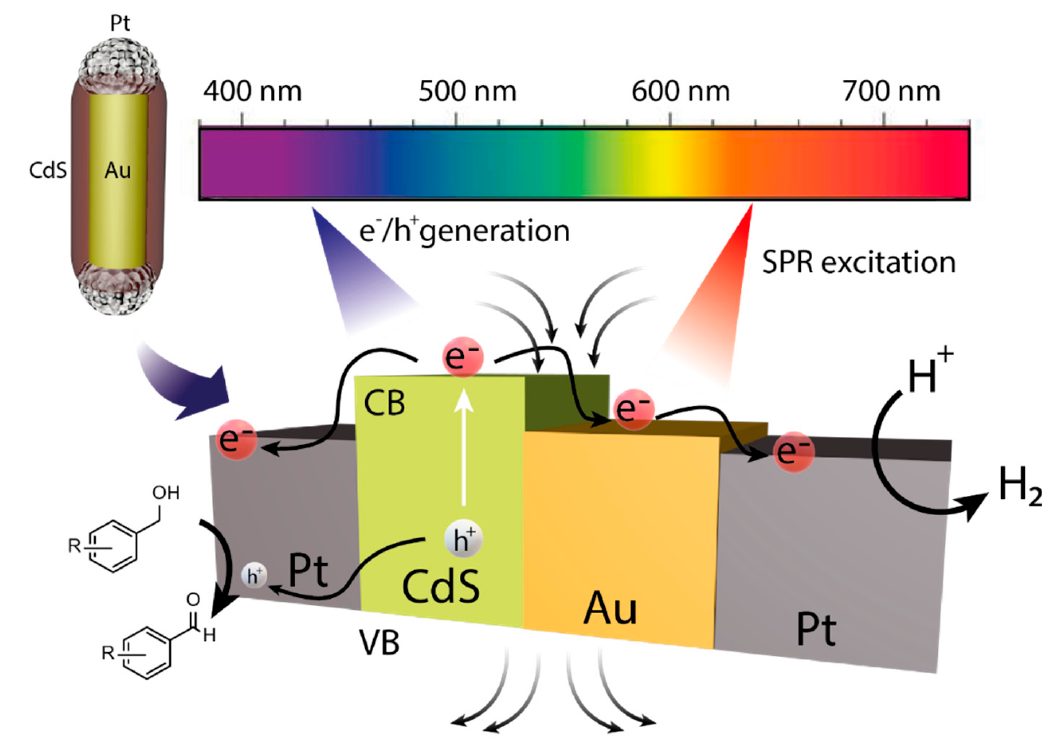
Figure 10. Schematic representation of the energy band multichannel in bimetallic@CdS heterostructures (adapted from [136]); semiconductor charge separation under visible light irradiation and its further electron migration through AuNRs to enhance tipped Pt reservoir; Induced both the resonance energy transfer (RET) and hot electron transfer processes and synergistically boosted the photocatalytic reaction (adapted from [136]).